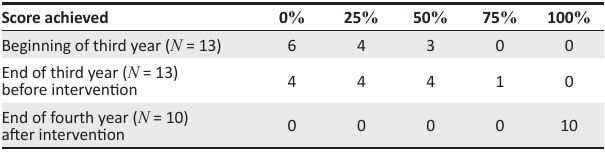
TABLE 4: Dosage results for stratified sample of students given one-on-one teaching. Score achieved